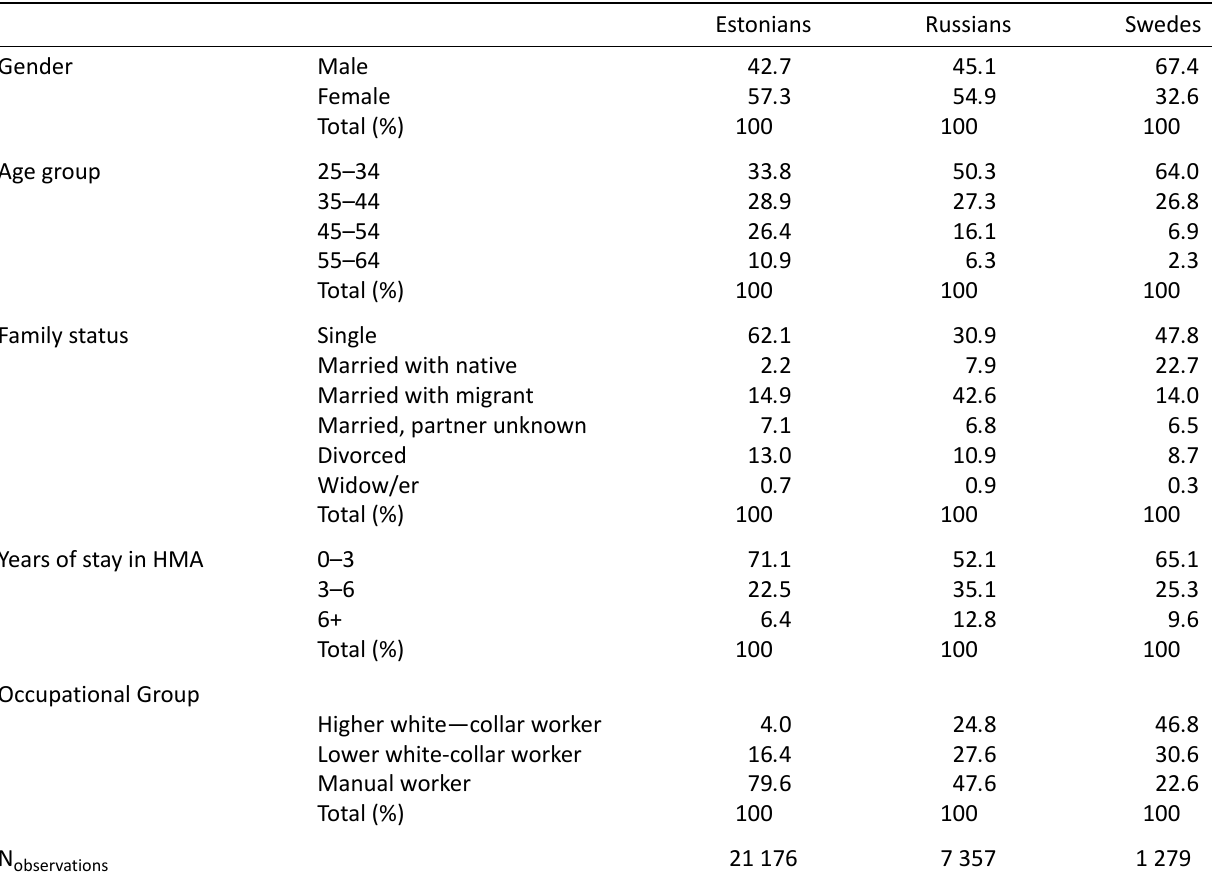
Table 1. Characteristics of the research population by country of